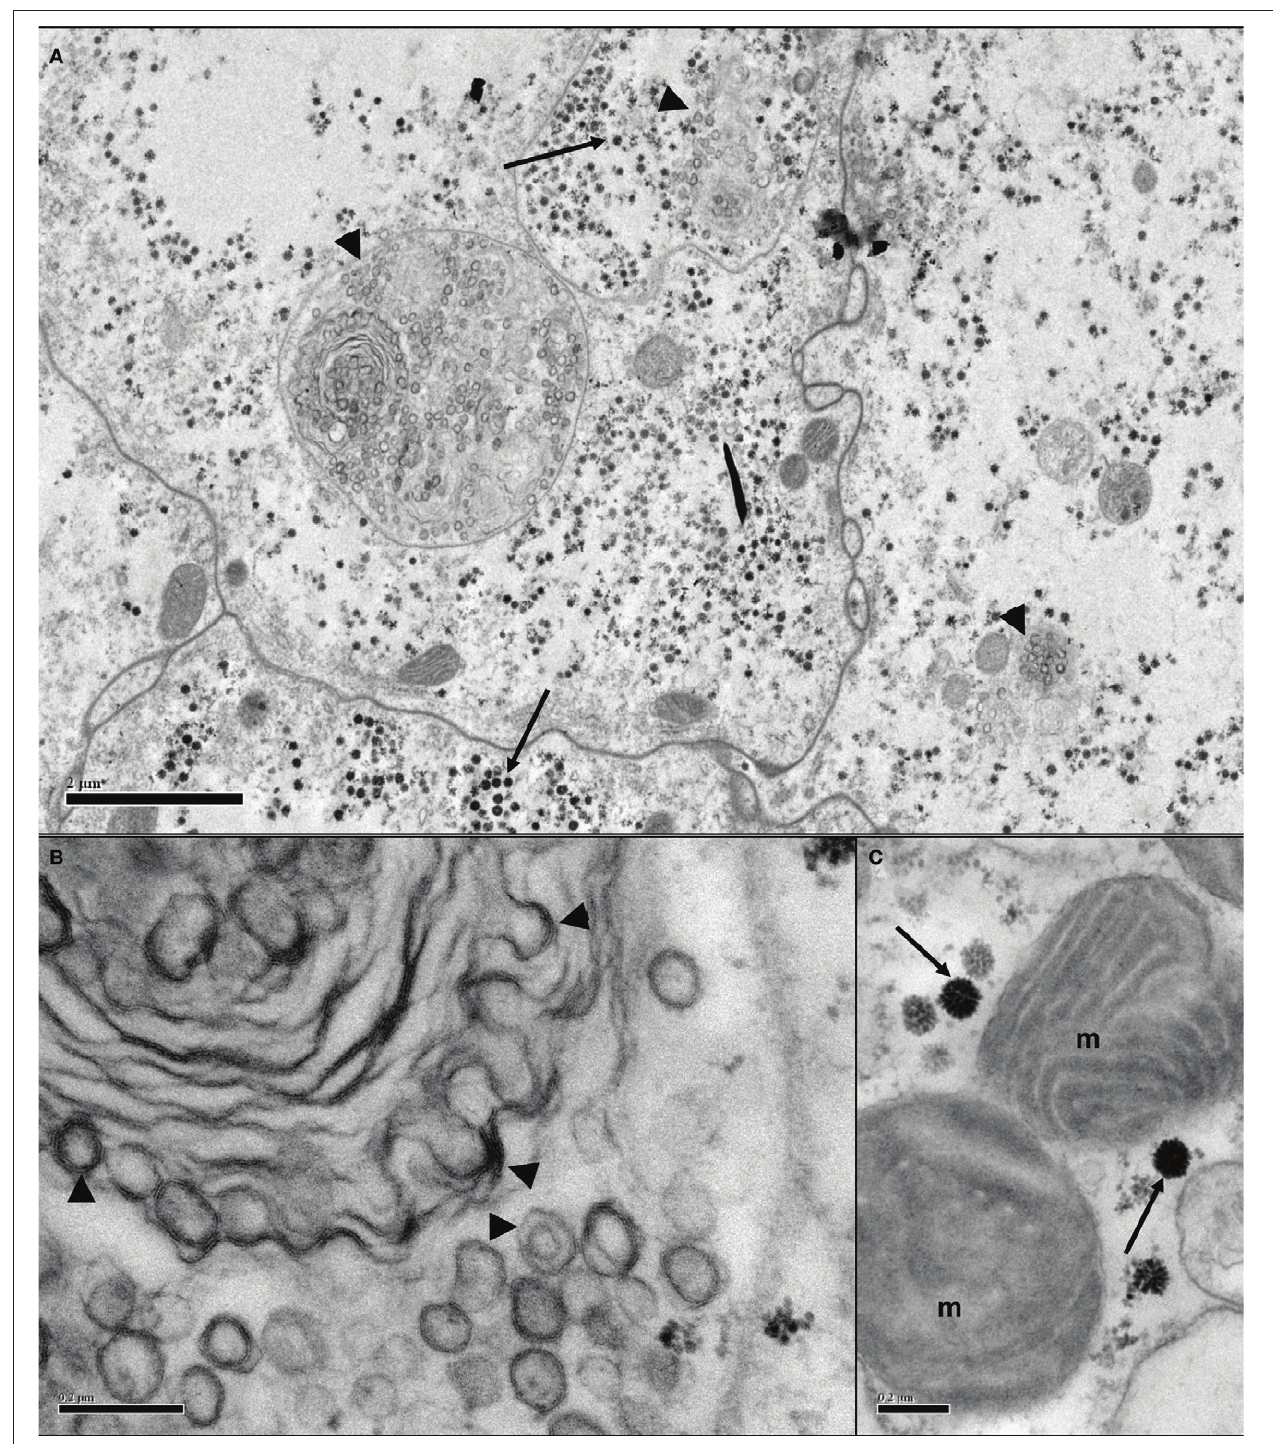
FIGURE 3 | Transmission electron micrographs of Ornithodoros moubata cell line OME/CTVM26 showing putative endogenousviruses. (A) Several adjoining cells containing putative reovirus-like (arrows) and bunyavirus-like (arrowheads) particles in both individual and shared cellular compartments.